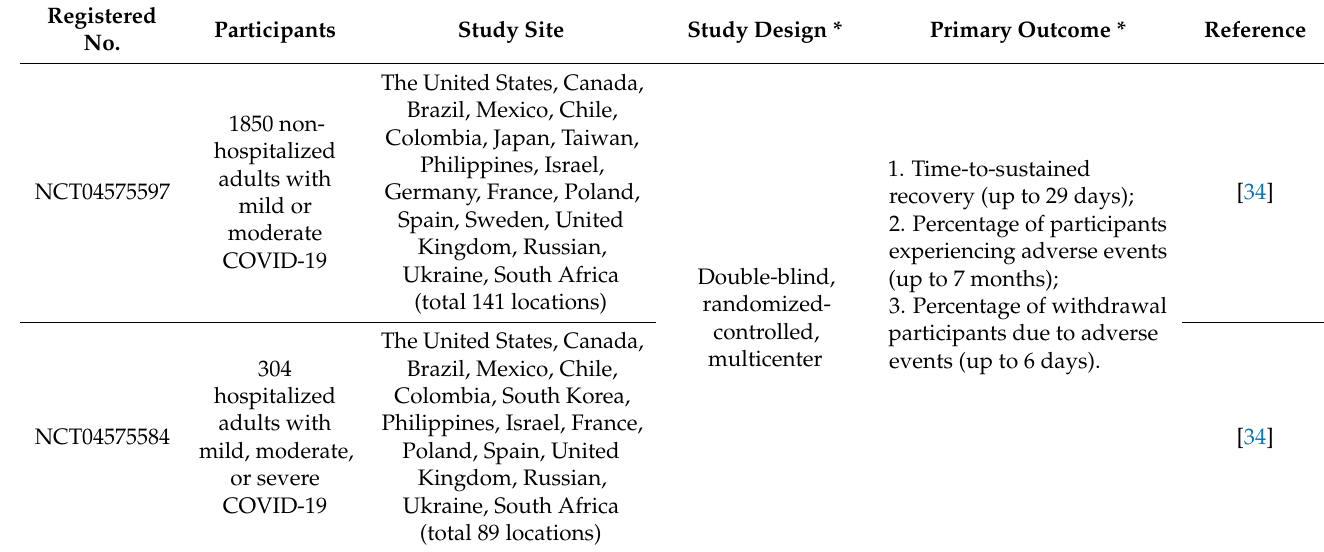
Table 3. Ongoing phase-III trials of